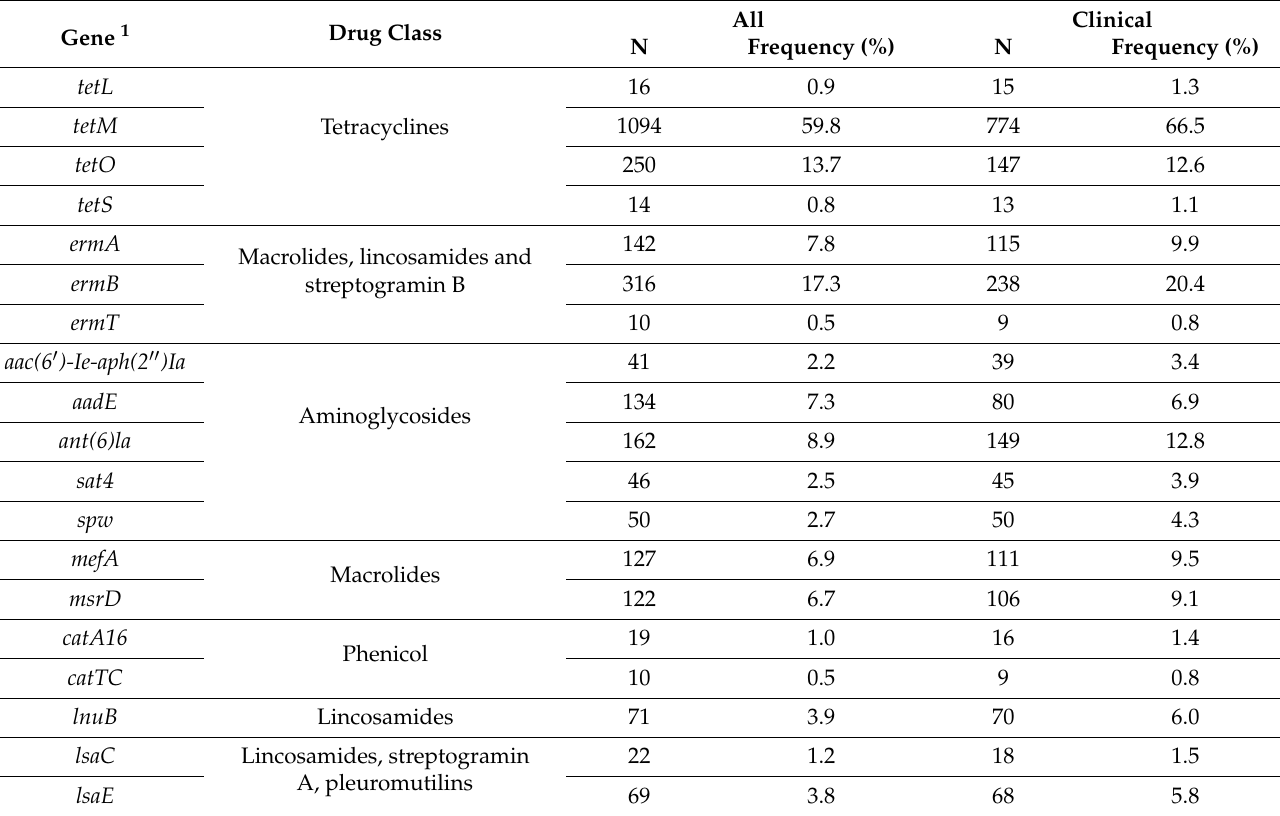
Table 4. Distribution of antimicrobial resistance genes in NPDIB S. agalactiae